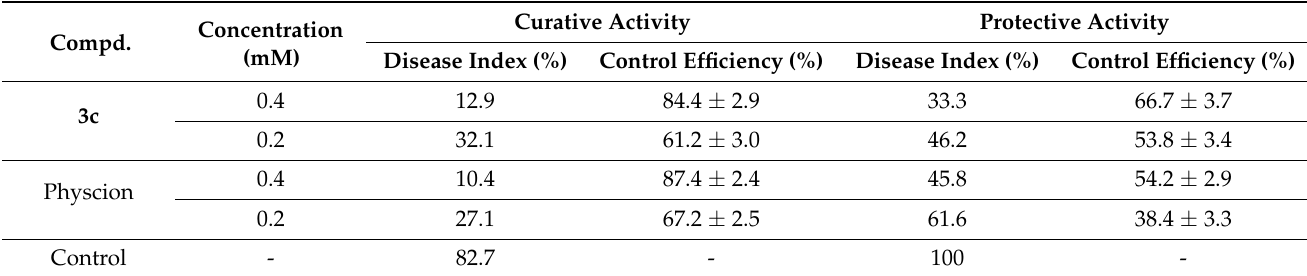
Table 2. Protective and curative activities of compound 3c in